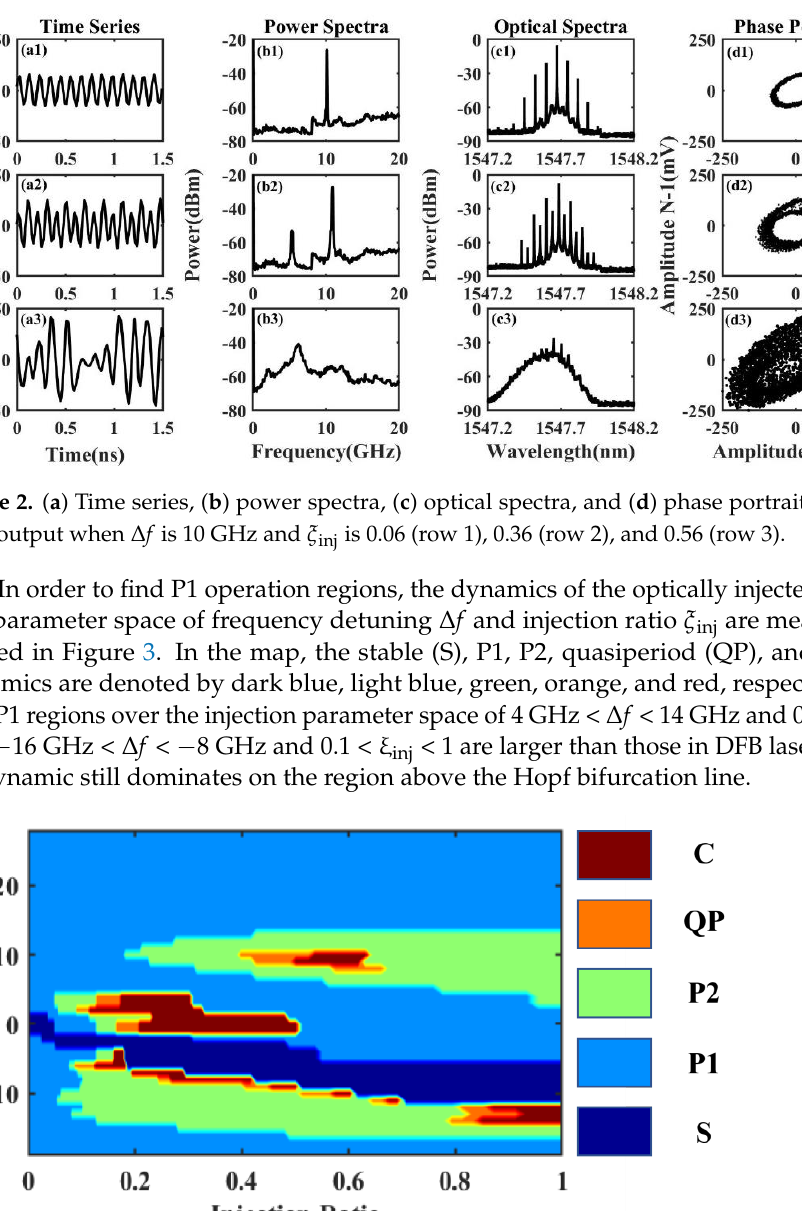
Figure 3. Dynamical map of the optically injected DM laser.